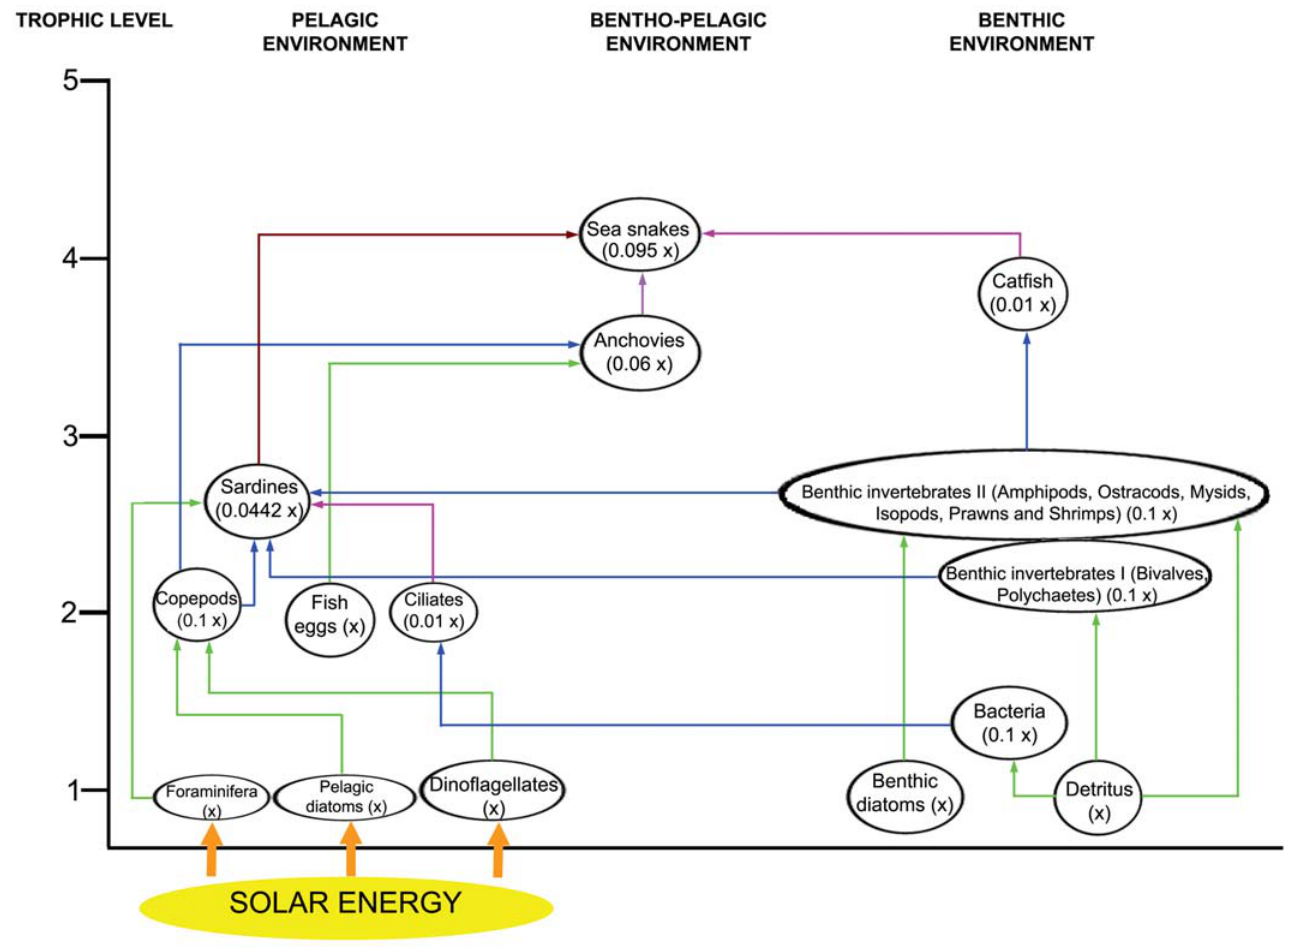
Figure 3. Flow chart depicting hypothetical food chain and energy flow of sea